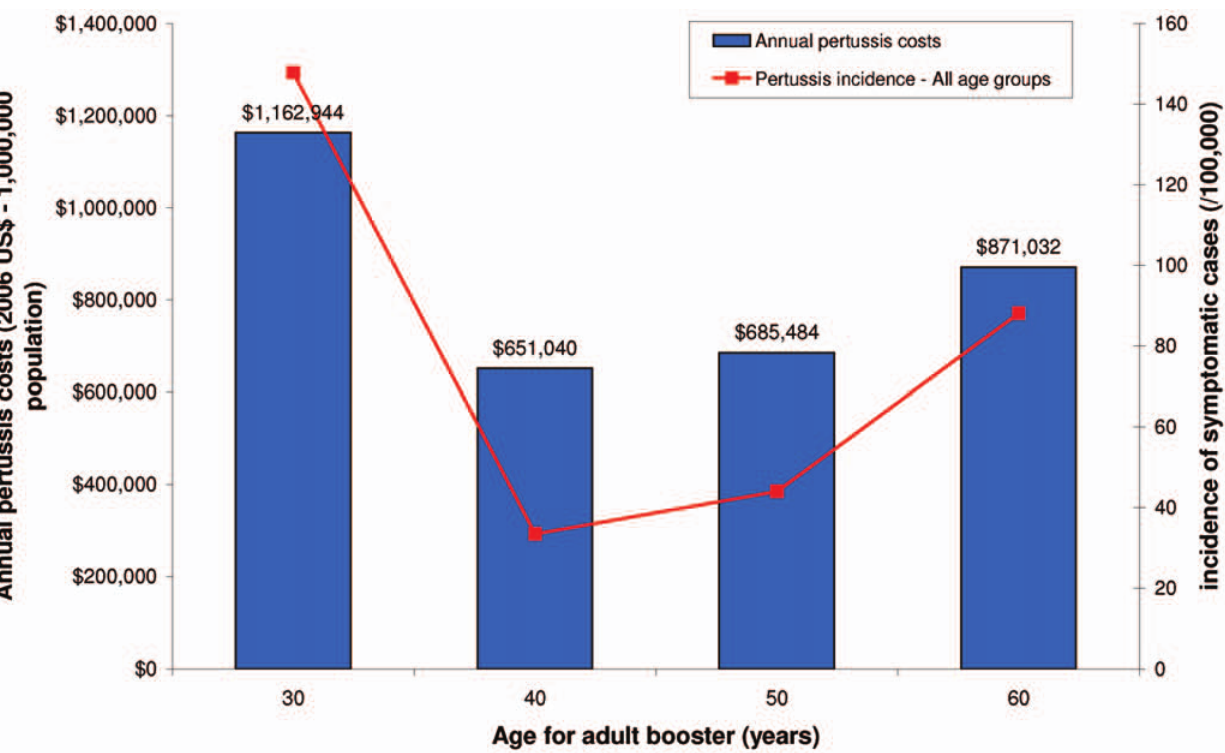
Figure 2. Variation in pertussis incidence and costs according to the age at which the adult booster dose is administered (Childhood vaccination + adolescent + cocoon + 1 booster dose for adult vaccination - steady-state situation).